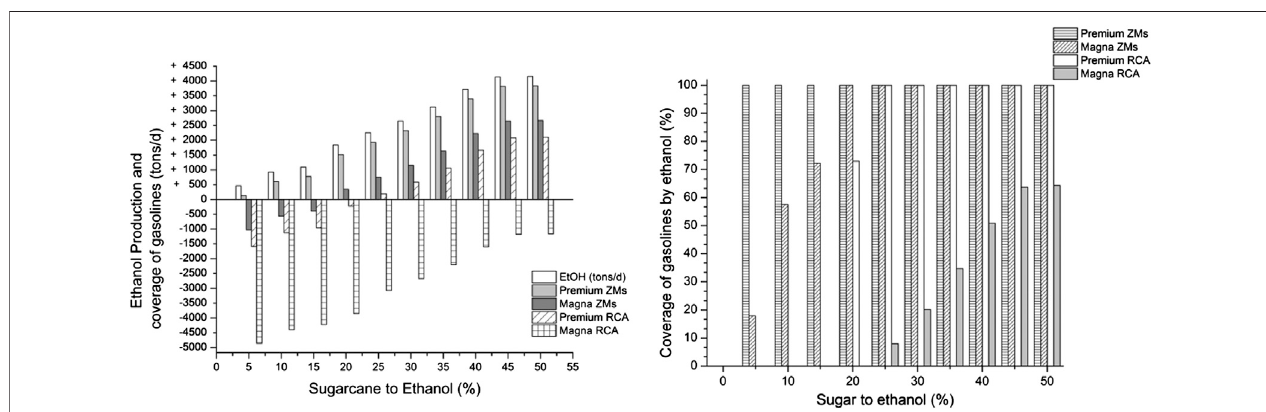
FIGURE 9 | Ethanol production and use in gasolines (left) and coverage of gasolines (%) by ethanol in Mexico.